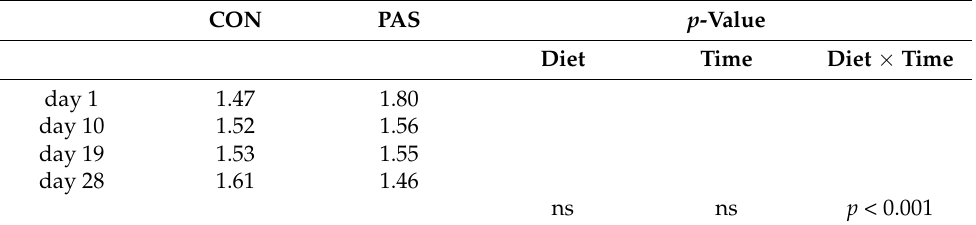
Table 4. Salivary IgA concentrations expressed as Log in the two experimental groups.